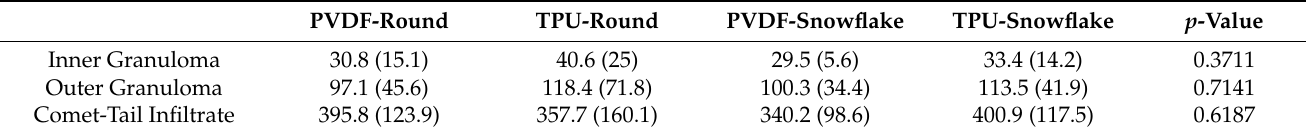
Table 1. Microscopic characteristics of the different threads. There were no statistically significant differences between the tested materials in either granuloma size or comet-tail infiltrate. Abbreviations: PVDF: polyvinylidene fluoride, SD: standard derivation, TPU: thermoplastic polyurethane. Data are represented as the mean (SD).